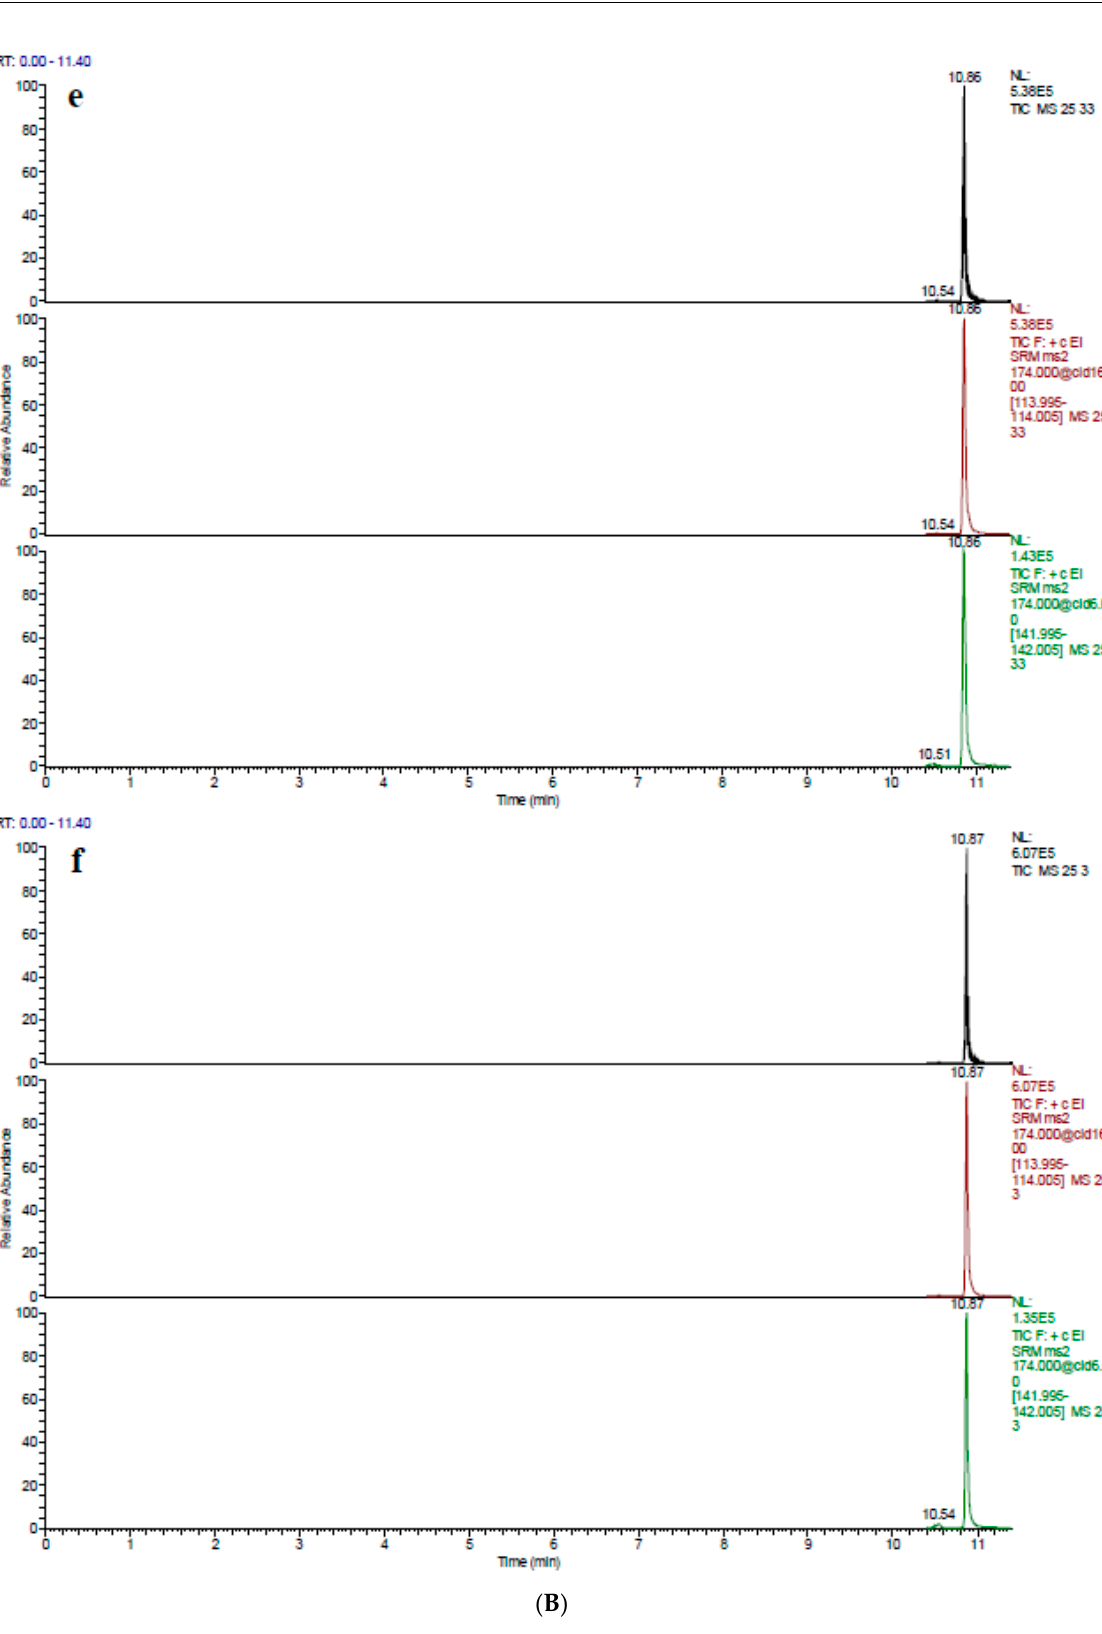
Figure 3. ( A ) Total ion chromatograms (TICs) and quantitative and qualitative ion chromatograms of blank chicken whole egg ( a ), albumen ( b ) and yolk ( c ), and duck whole eggs ( d ), albumen ( e ) and yolk ( f ). ( B ) Total ion chromatograms (TICs) and quantitative and qualitative ion chromatograms of blank chicken whole egg ( a ), albumen ( b ) and yolk ( c ), and duck whole egg ( d ), albumen ( e ) and yolk ( f ), spiked with 25.0 μ g/kg penicillin G.